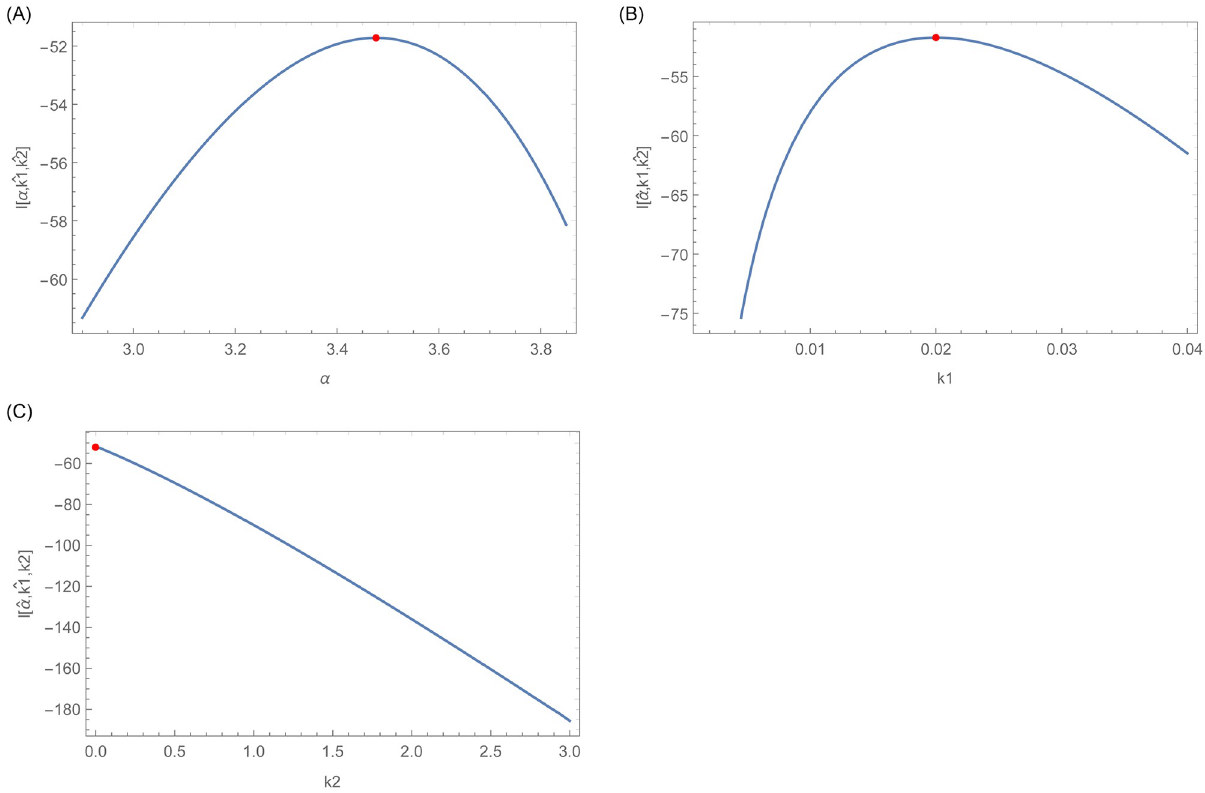
Fig 20. This figure indicates that the log likelihood roots are global maximum for the second data